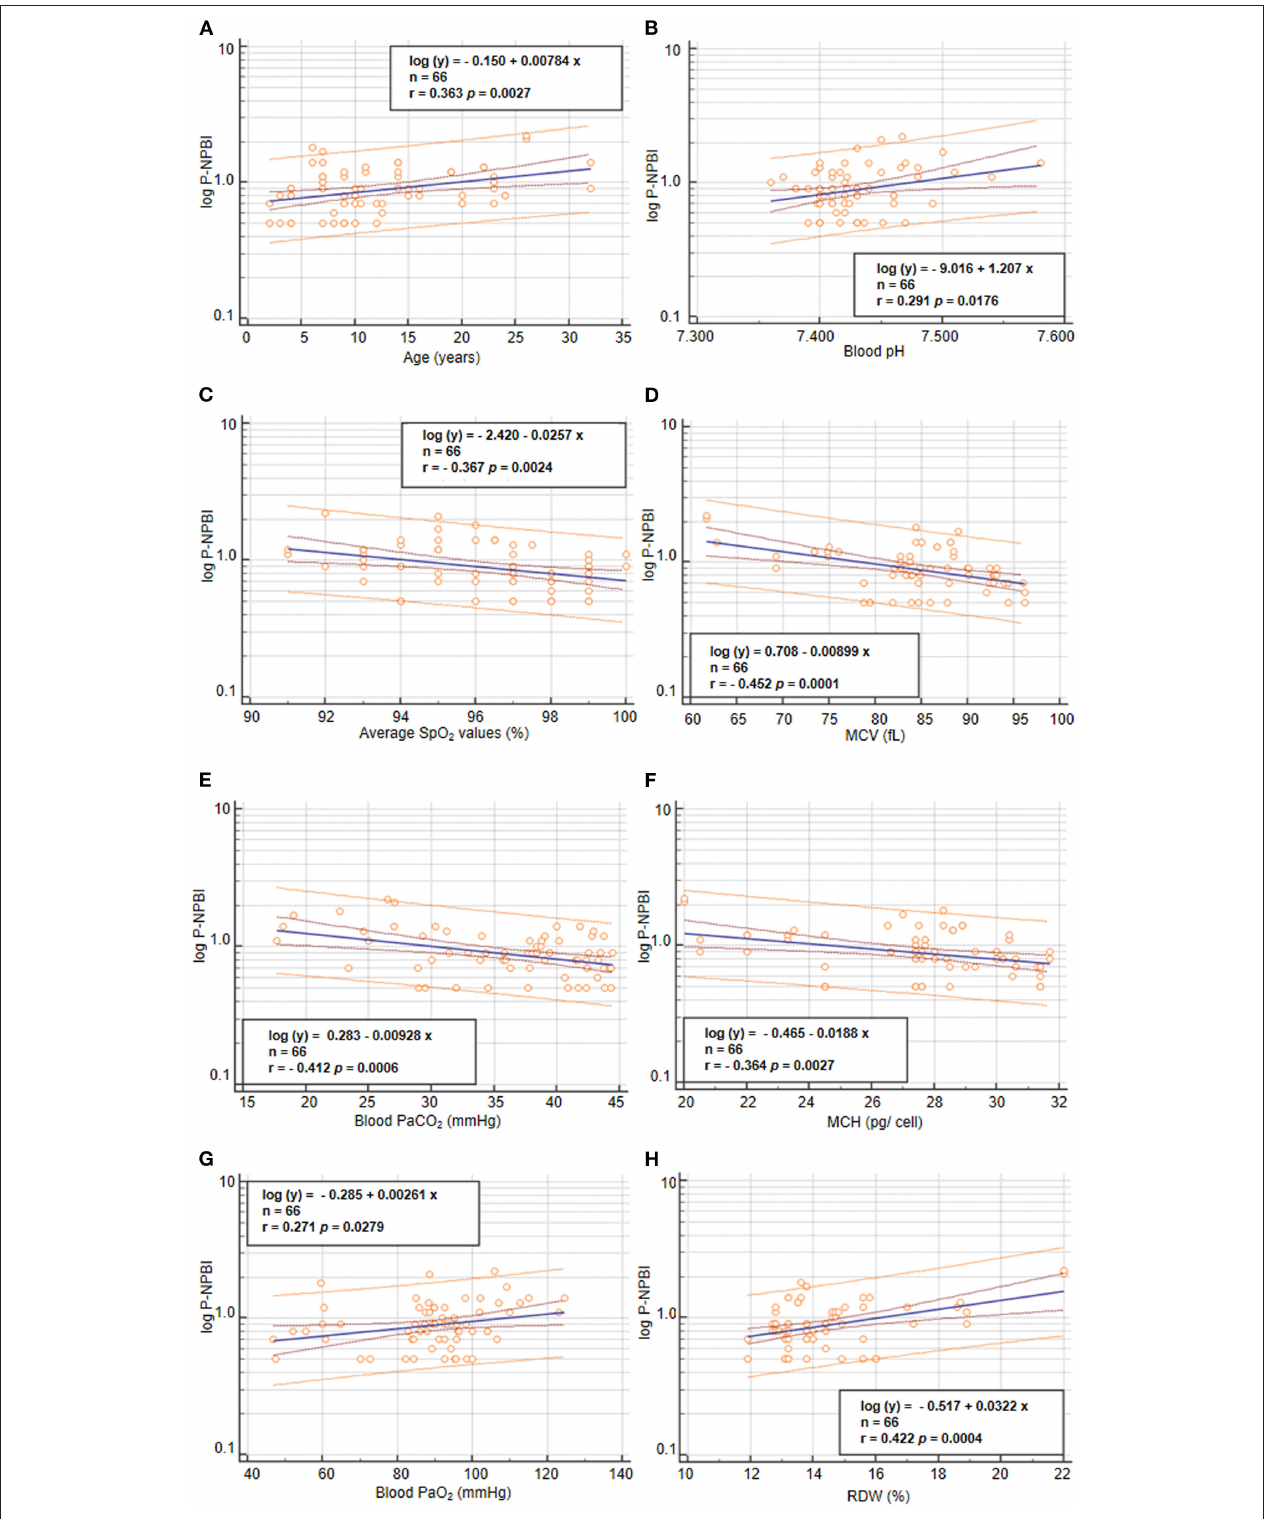
FIGURE 5 | Correlations between P-NPBI and (A) age, (B) blood pH, (C) average SpO 2 , (D) MCV, (E) blood PaCO 2 , (F) MCH, (G) blood PaO 2 , and (H) RDW in the population with RTT ( n = 66). P-NPBI concentrations are log-transformed to fit normal distribution. P-NPBI, plasma non-protein-bound-iron; SpO 2 , peripheral oxygen saturation; MCV, mean corpuscular volume; PaCO 2 , partial arterial pressure of carbon dioxide; MCH, mean cell hemoglobin content; PaO 2 , partial arterial pressure of oxygen; RDW, red cell distribution width. Inner dashed lines represent 95% confidence interval of regression. Outer lines represent 95% confidence interval of the predicted